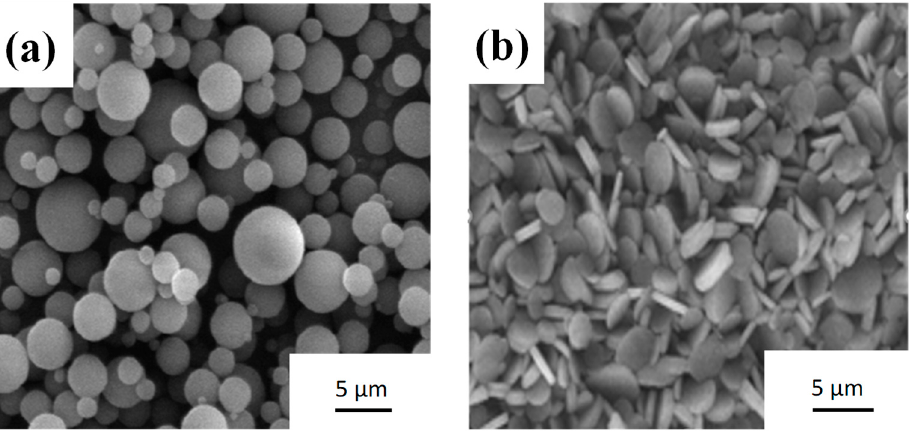
Figure 1. SEM images of ( a ) PMMA and ( b ) h-BN powder.